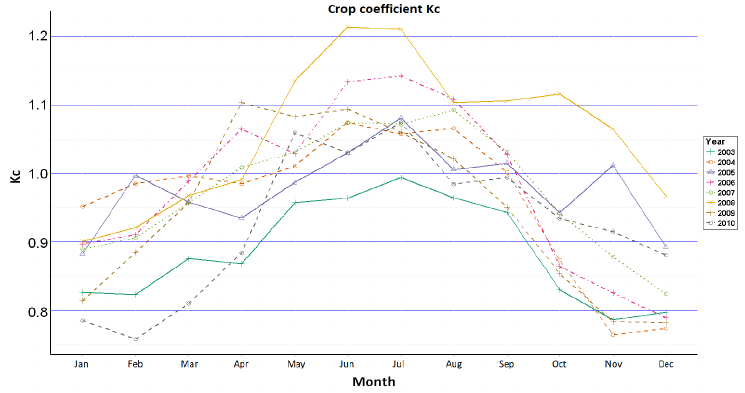
Figure 5. Monthly crop coefficient (K c ) derived from the ratio between the ensemble ET and reference